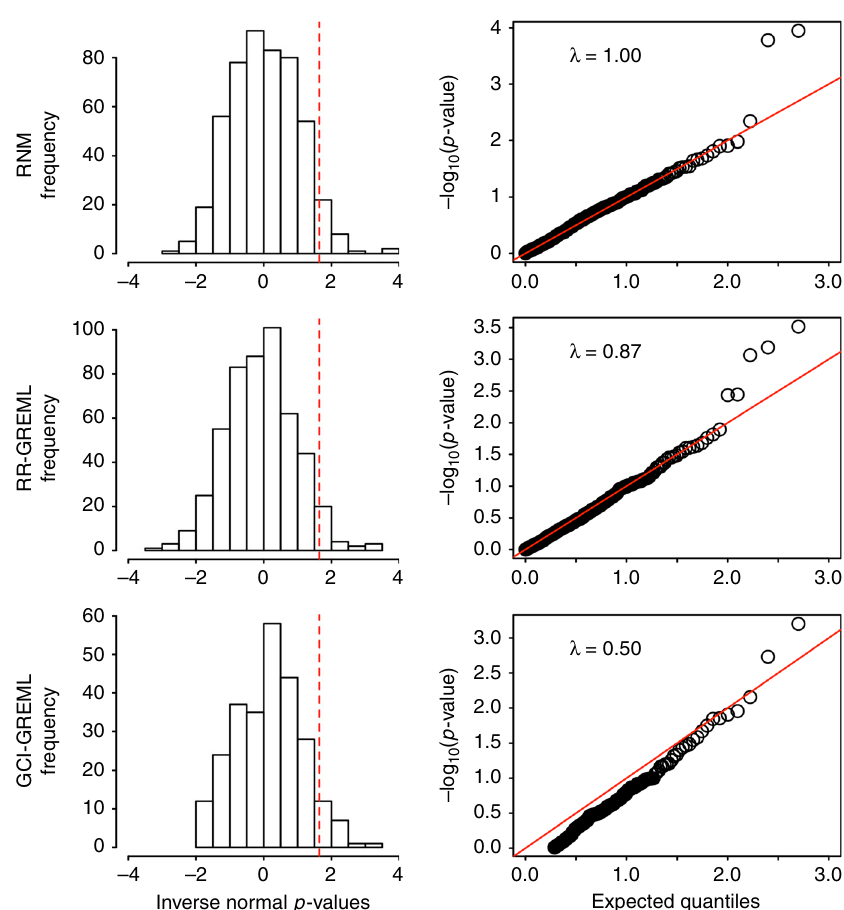
Fig. 2 Type I error rate for detecting G – C interaction is under control. Five hundred replicates of data were simulated under a null model that assumed no genotype – covariate interaction. Simulation was based QCed ARIC data consisting 7,263 individuals and 583,058 SNPs. The model is speci fi ed as y = α + α + e with c = β + ε , all effects drawn from a multivariate normal distribution, where the variance – covariance structure between α 0 1 × c 1 0 0 this order) is 0 1